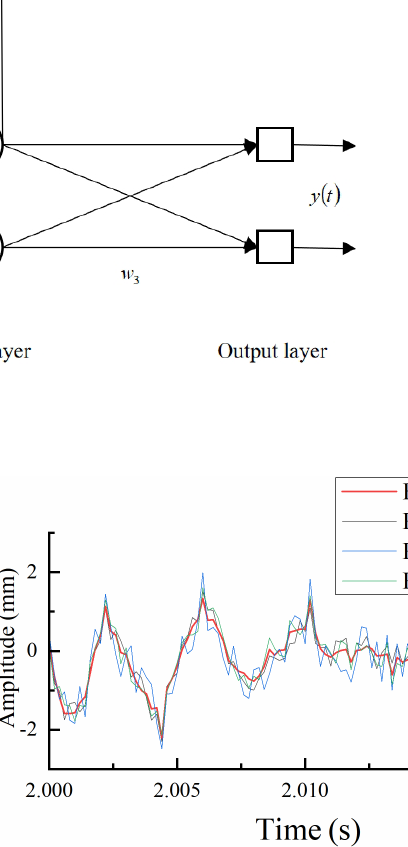
Figure 8. The prediction results of the different neural